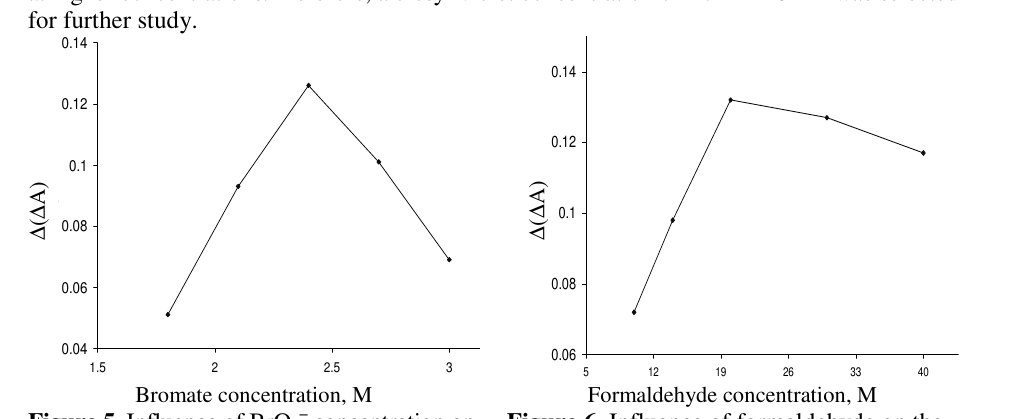
Figure 6 . Influence of formaldehyde on the analytical signal . Conditions: H 2 SO 4 , 0.3 M; Cresyl violet 1.24×10 −4 M ; BrO 3− 2.4 ×10 −4 M; Temperature,